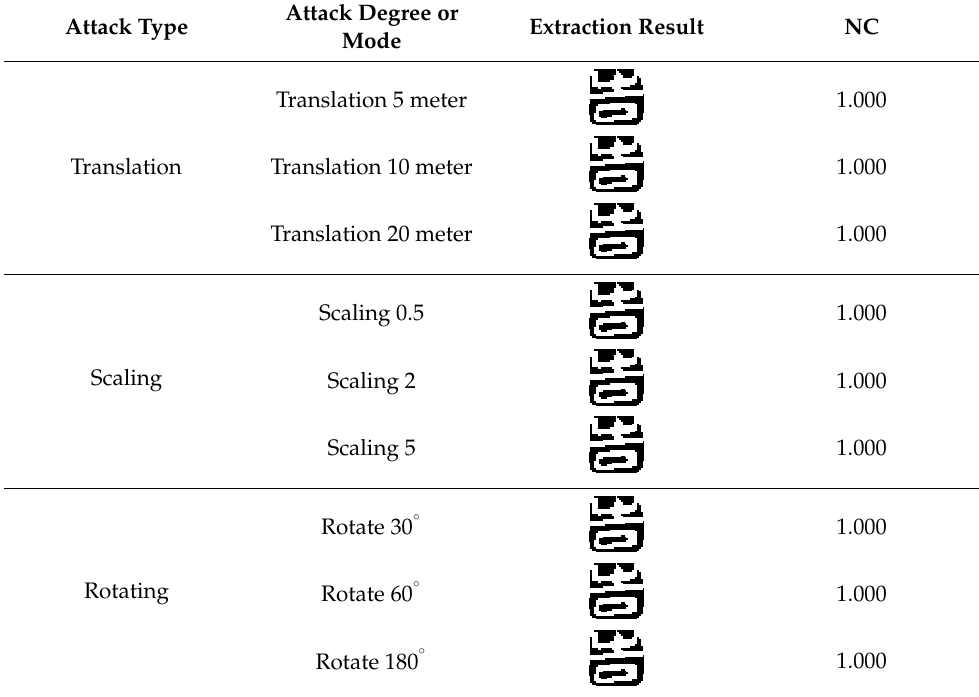
Table 2. Watermark extraction results under translation, scaling, and rotating attacks.